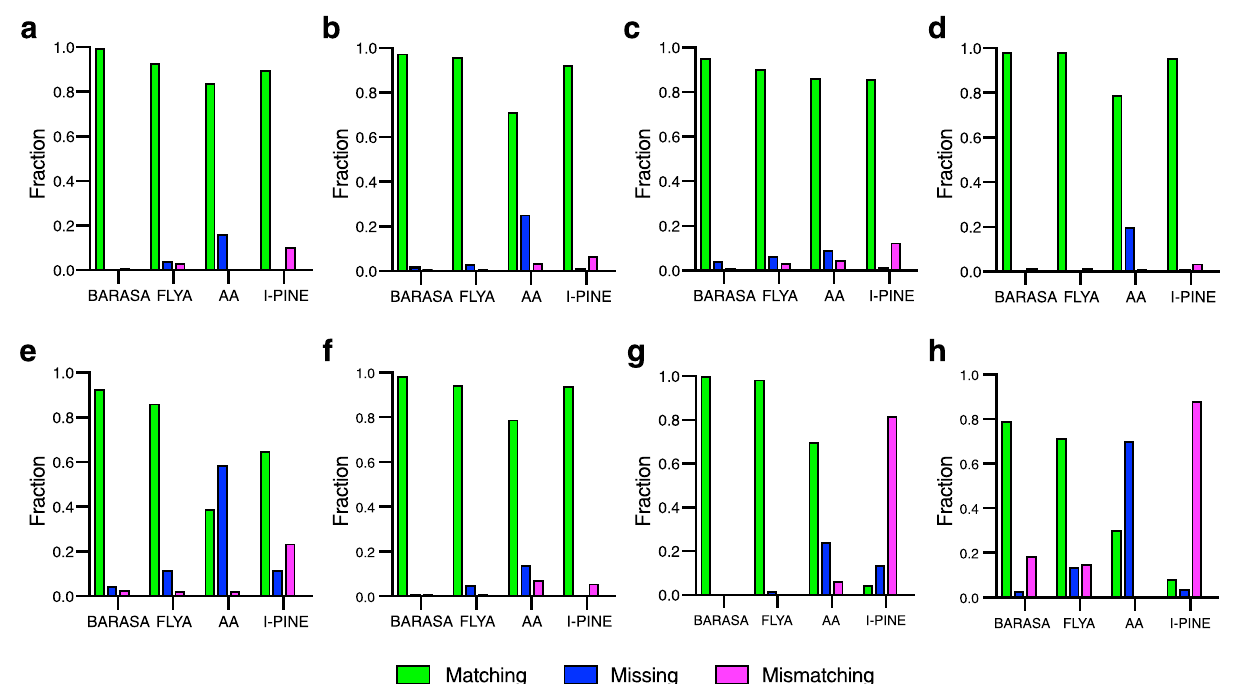
Fig. 5 | Comparison of BARASA against other assignment algorithms. Perfor- mance of BARASA, FLYA, AutoAssign (AA), and I-PINE against reference triple resonance assignments of six protein systems: a IL-1 β ; b IL-1Ra; c IGPS; d MBP; e CY1; f ecTS; g V5dm; h hIDD. Shown are the fractions of residues that are accu- rately matched to the reference assignments (green), incorrectly matched